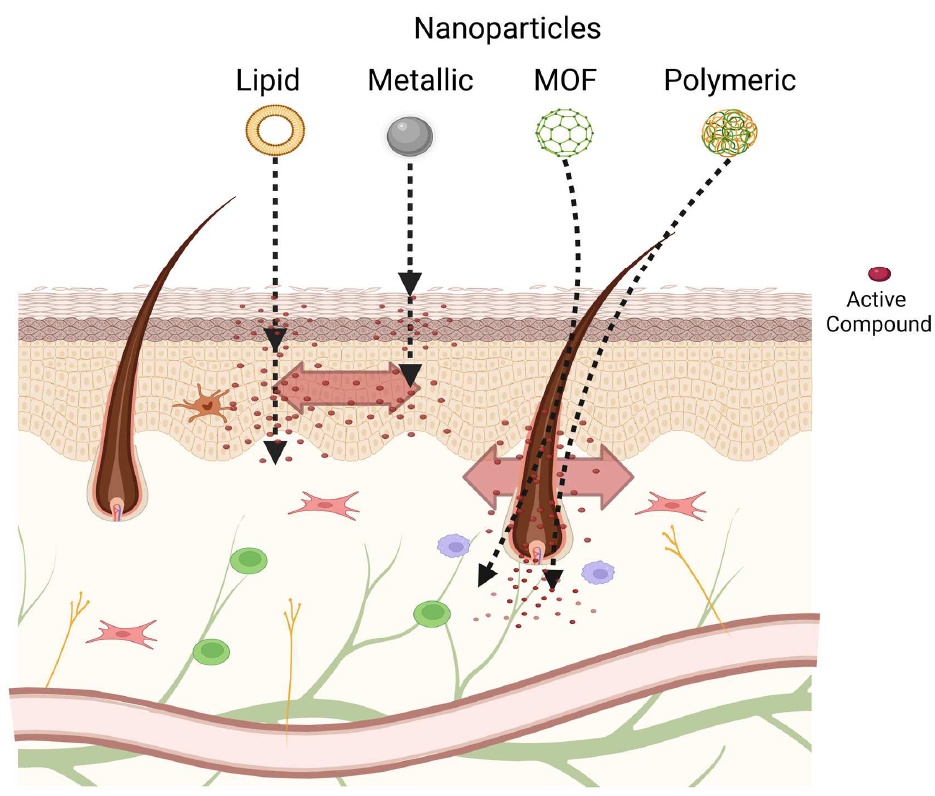
Figure 2. Scheme of potential skin penetration routes of different types of nanoparticles.